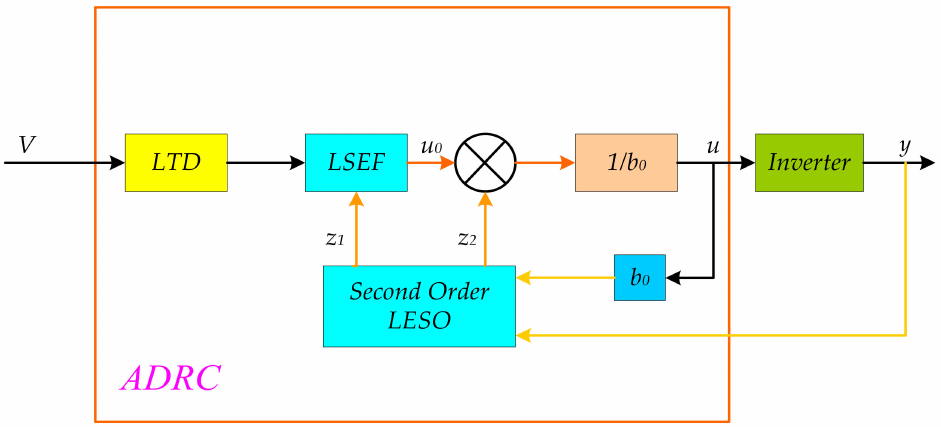
Figure 4. Structure of active disturbance rejection